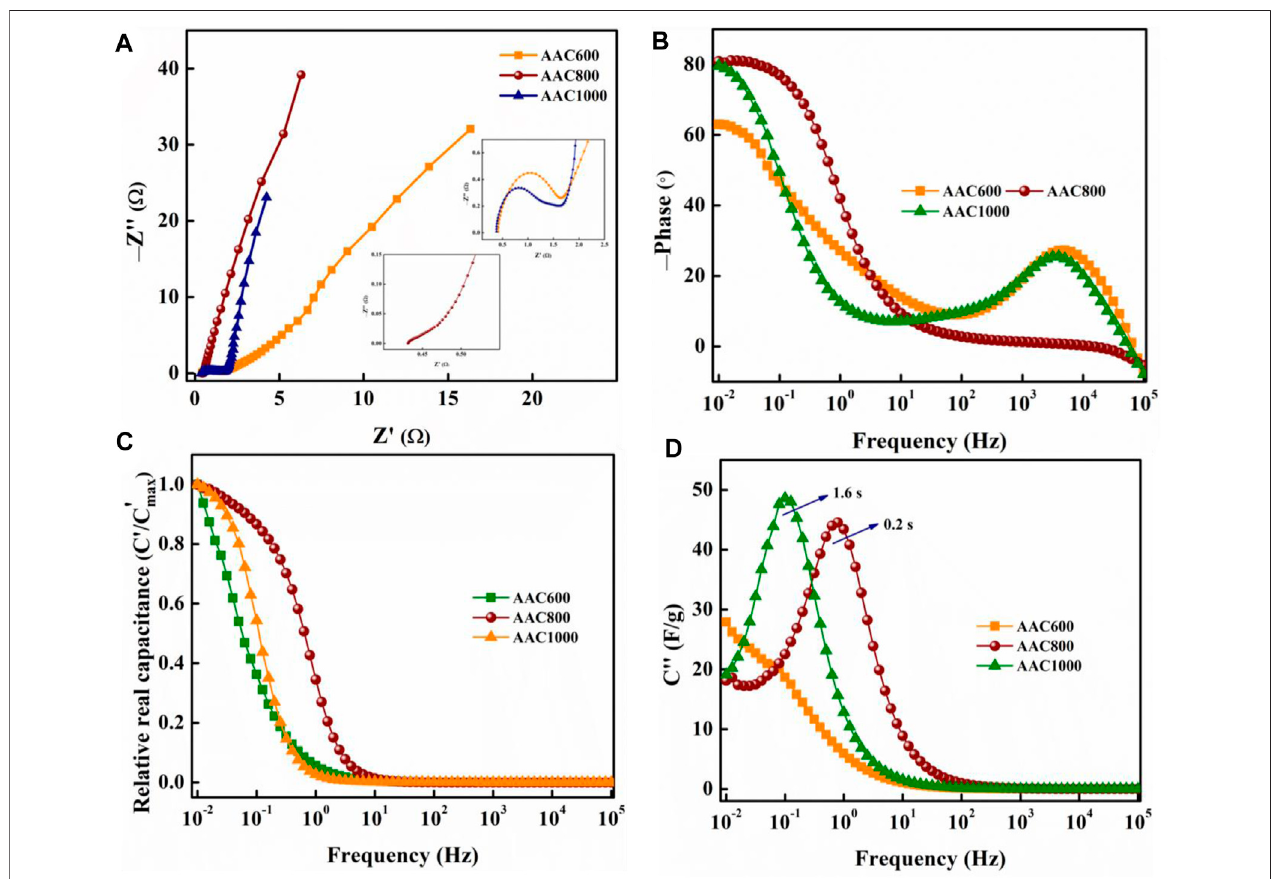
FIGURE 7 | Nyquist impedance plot of AACs (A) ; inset (i) shows the high-frequency region ofAAC600 and AAC1000; inset (ii) shows the high-frequency region of AAC800; Bode phase angle plot of AACs (B) ; relative real (C) and imaginary capacitance (D) of AACs as a function of frequency.